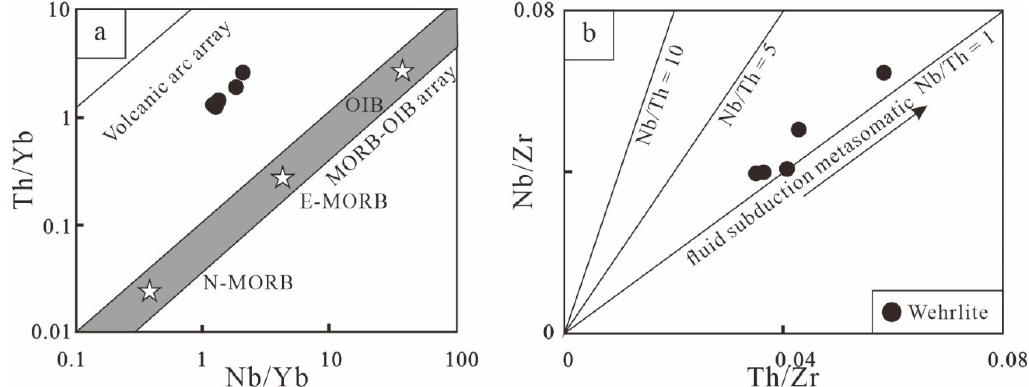
Figure 10. Nb/Yb-Th/Yb ( a ) and Th/Zr-Nb/Zr ( b ) diagrams. Figure 10a is modified from [47] and Figure 10b is modified from [68].